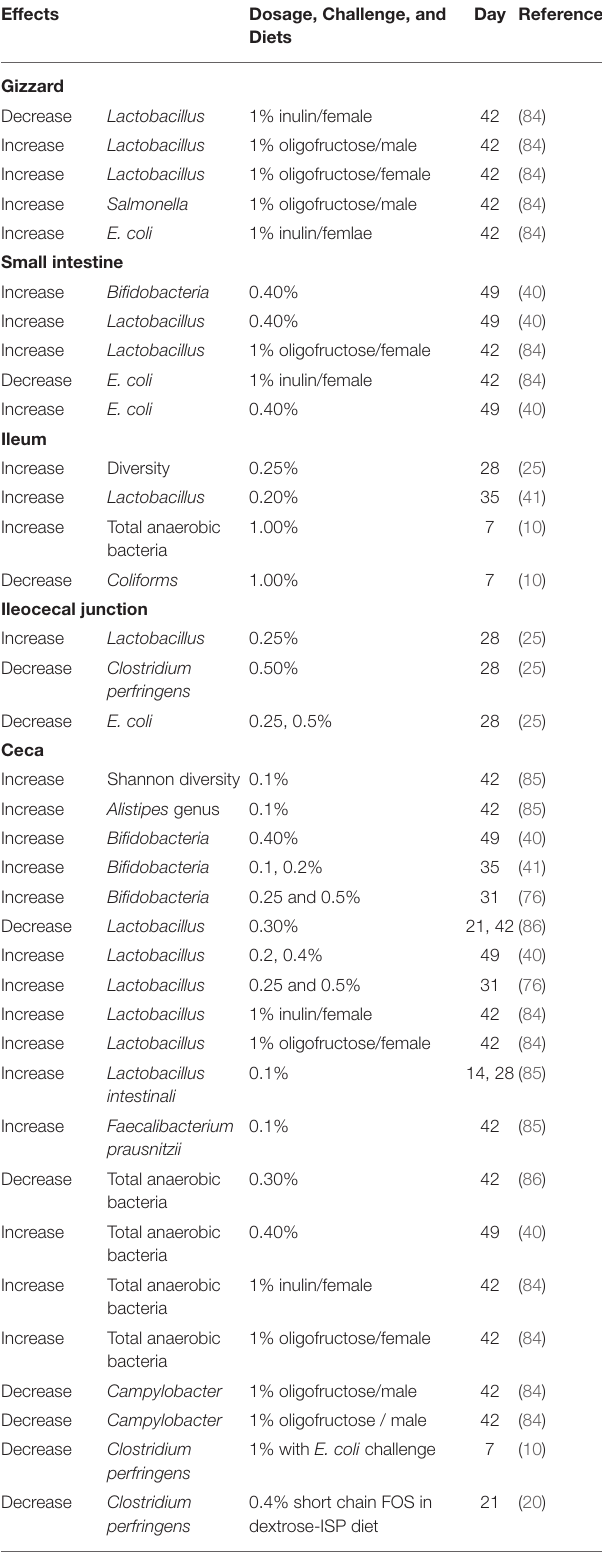
TABLE 4 | Effects of fructans on intestinal microbiota of